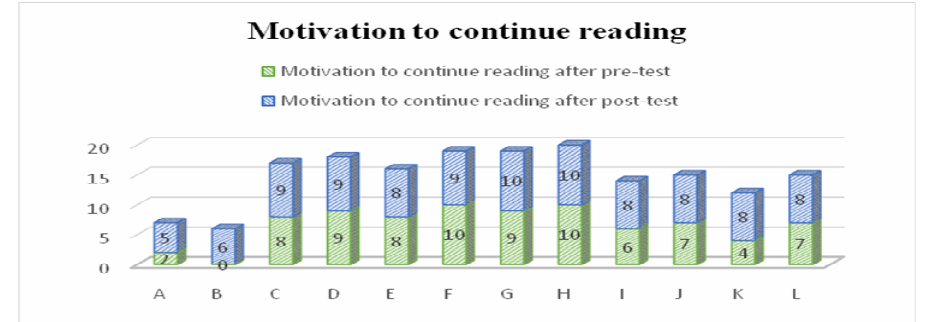
Figure 3. Motivation ratings after pre and post-tests